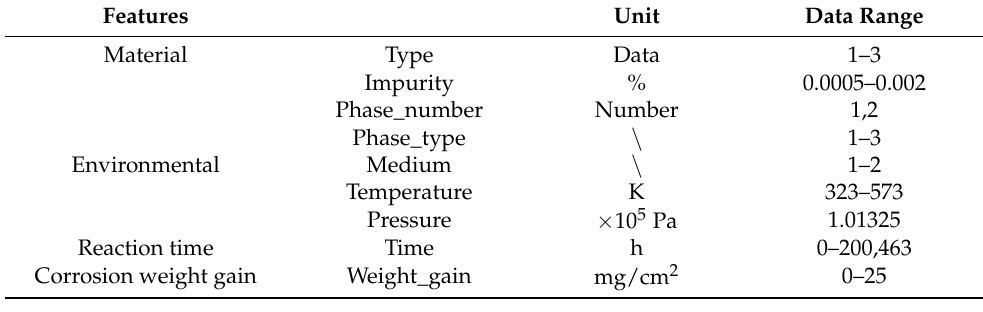
Table 1. Description of features in corrosion data.